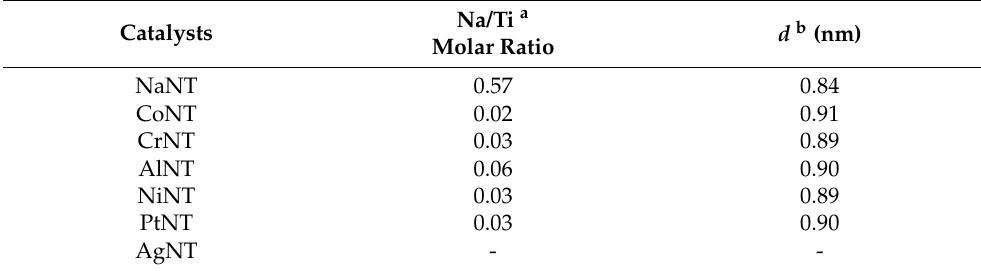
Figure 1. ( a ) XRD diffractograms, ( b ) Raman and ( c ) FTIR spectra of the catalysts studied. The main hkl reflections of Na 2 Ti 3 O 7 are shown in parenthesis above the diffraction lines. Table 1. Physicochemical properties of the catalysts studied. The Na/Ti molar ratios are obtained by EDS analyses whereas the interwall distances are taken through XRD